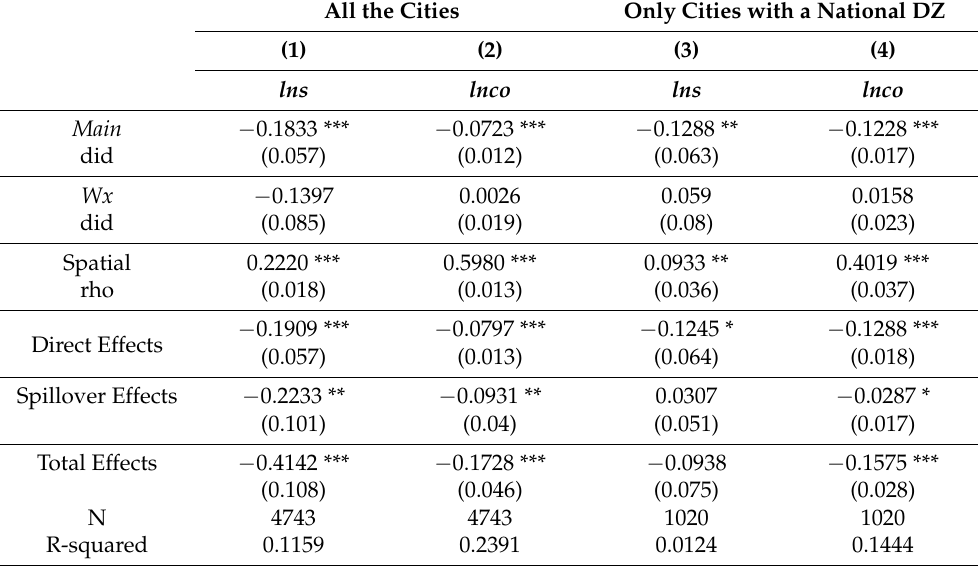
Table 11. Spatial spillover. All the Cities Only Cities with a National